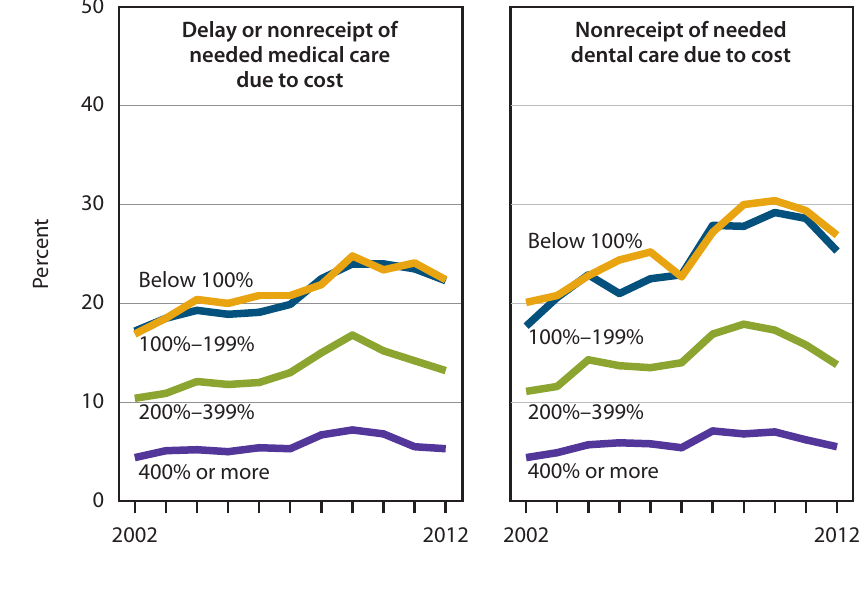
Figure 18. Delay or nonreceipt of needed medical care or nonreceipt of needed adults aged 18–64 who delayed or did not